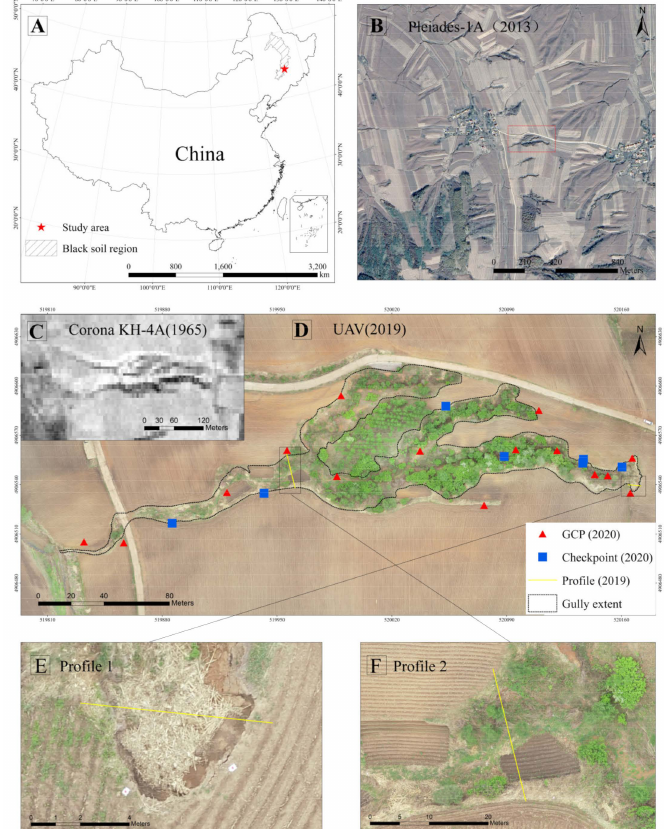
Figure 1. Location of the study area. ( A ) Typical black soil area in China; ( B ) Pleiades-1A imagery (2013) of the study area; ( C ) Corona KH-4A imagery (1965) of the gully; and ( D ) Phantom 4 RTK UAV imagery of the gully and distribution of the ground control points (GCPs). The geographic coordinate system and projection were set to CGCS2000_3_Degree_GK_CM_126E. Detailed map of Profile 1 ( E ) and Profile 2 ( F